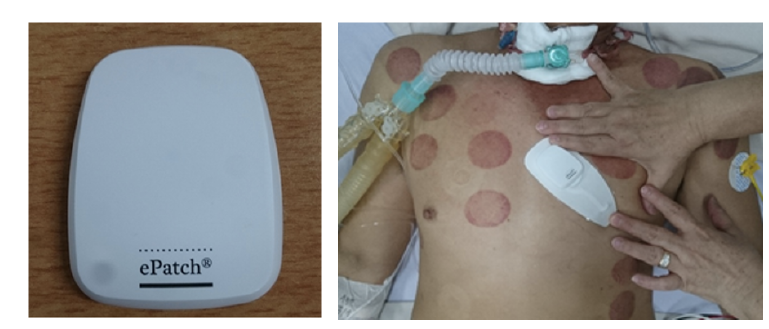
Figure 4. Wearable monitor for ECG data acquisition; ePatch ( left ) and example of ePatch placement on the chest ( right